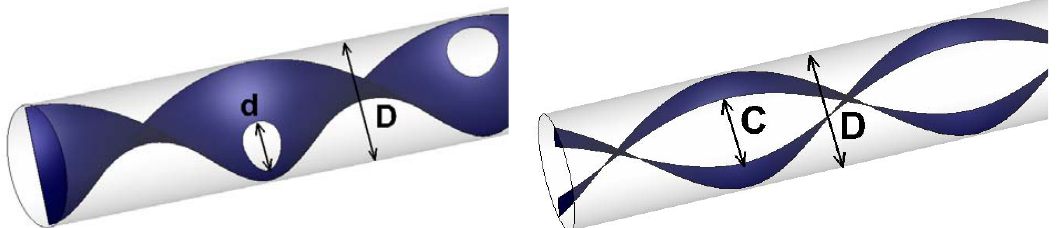
Fig. 3. Center-cleared and perforated tapes dimensional Fig. 3 Center-cleared and perforated tapes dimensional descriptions